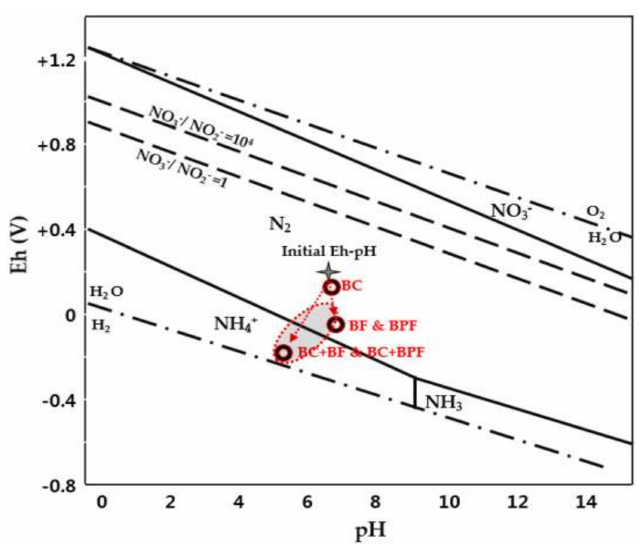
Figure 7. Changes in Eh-pH of BC, BF, BPF, BC + BF, and BC + BPF in single nitrate reactors plotted on the diagram edited by Eby, G.N.